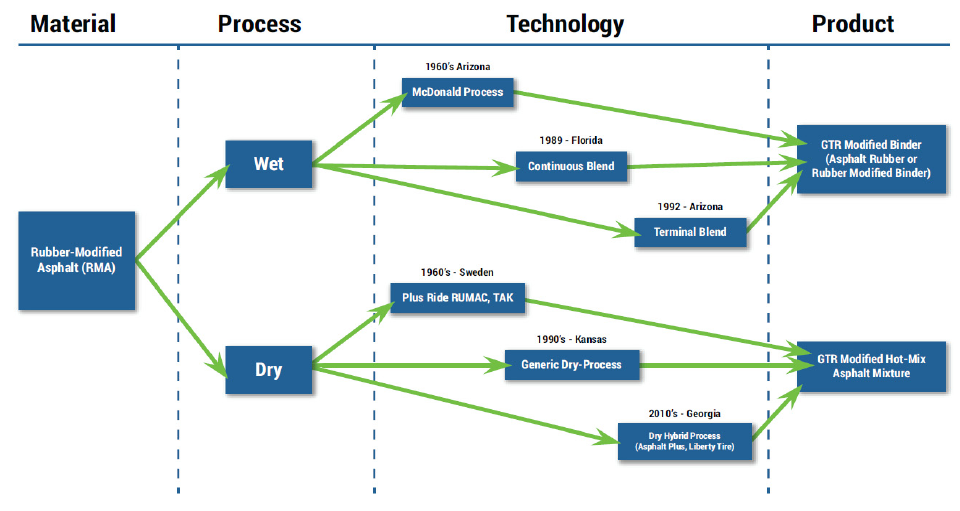
Figure 1. Development of rubber modification process [3].